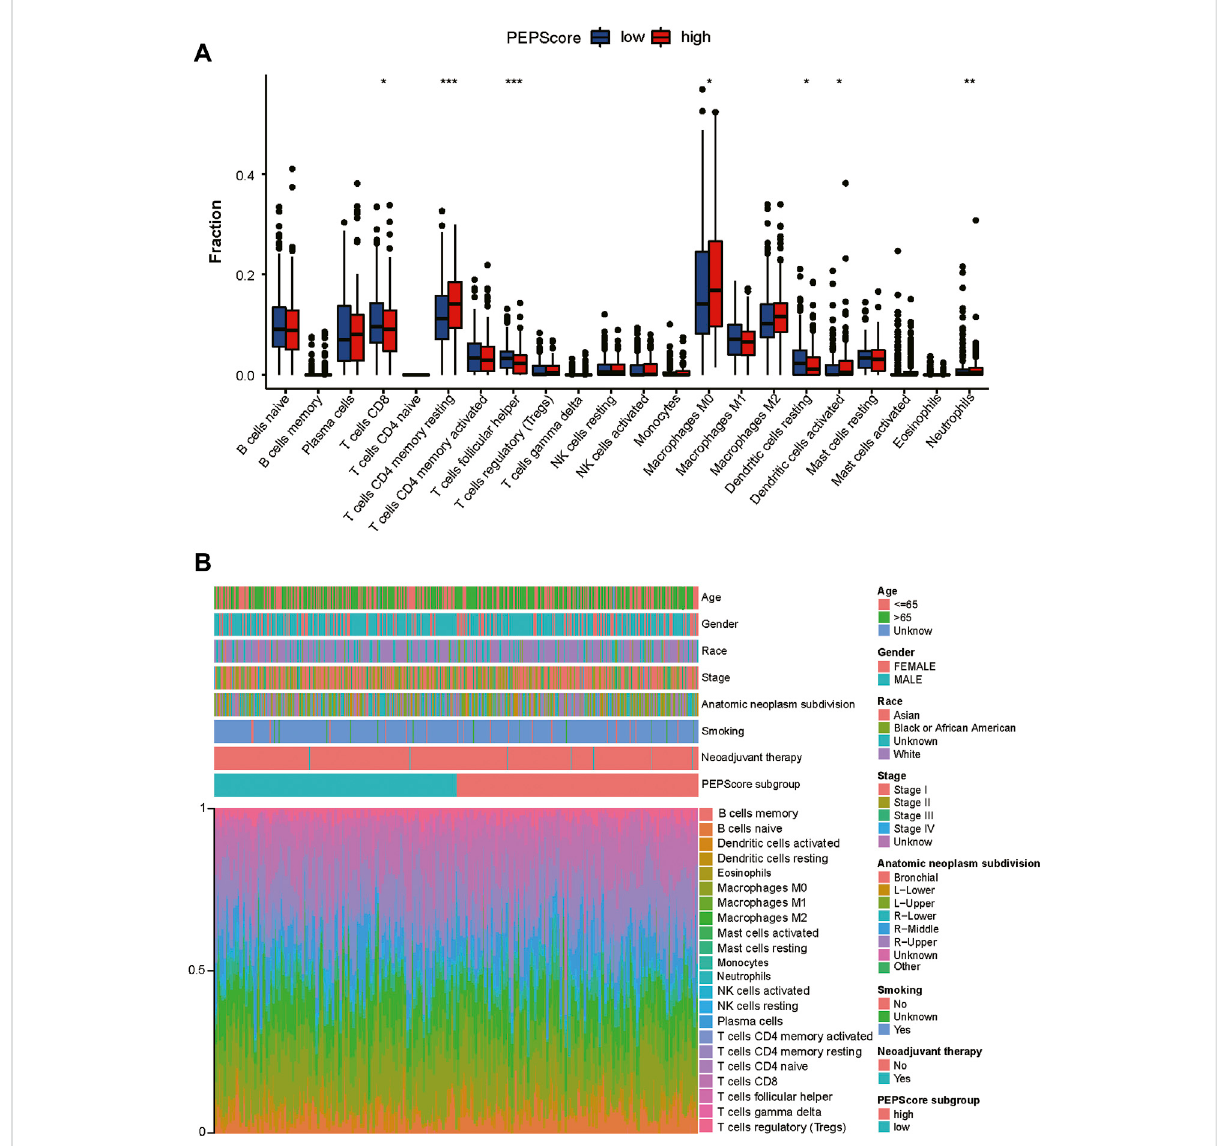
FIGURE 5 The landscape of the TME and the characteristics of different PEPScore subgroups. (A) The proportions of immune cells in the two PEPScore subgroups. The thick line in the box indicates the median value, whereas the dispersed dots indicate an outlier. The upper and bottom border of the box re fl ects the25thand 75th percentiles.Asterisk denotes the p -value (*: p < 0.05, **: p < 0.01, and***: p < 0.001). (B) PEPScore categorization and TEM cell proportions for 495 patients in the TCGA dataset. Patient annotations include gender, stage, race, age, smoking, and neoadjuvant